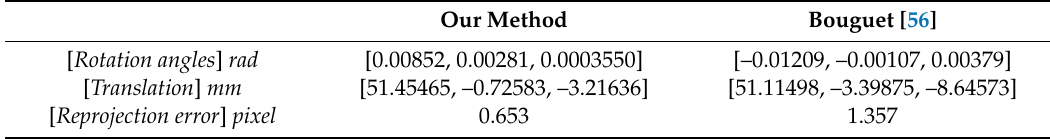
Table 3. Relative extrinsic parameters of